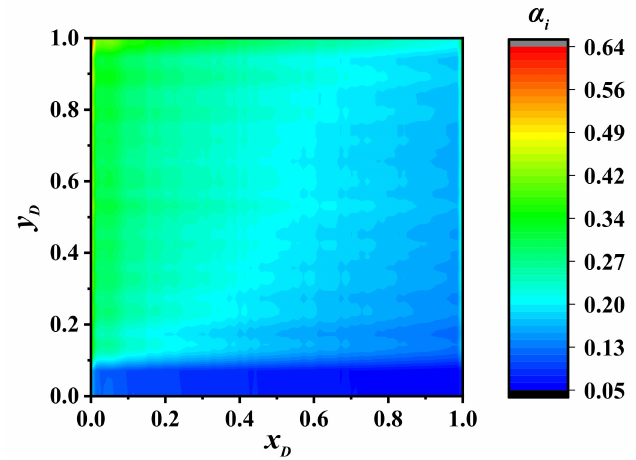
Figure 7. Spatial distribution of time scale 4 × 10 − 6 contribution in the natural